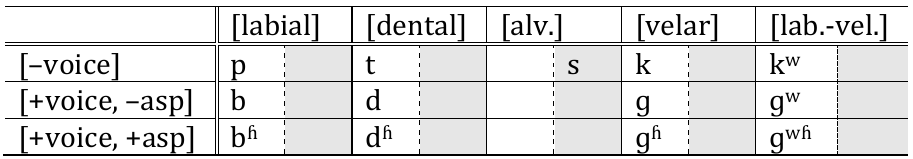
Table 9: The First Germanic Consonant Shift: stage 1 (initial